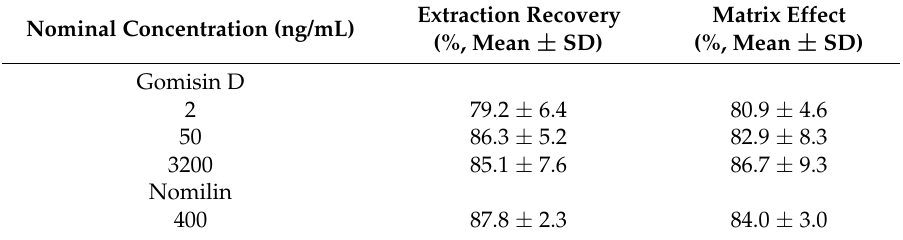
Table 2. Intra- and interday accuracy and precision for gomisin D in rat quality control (QC) samples.